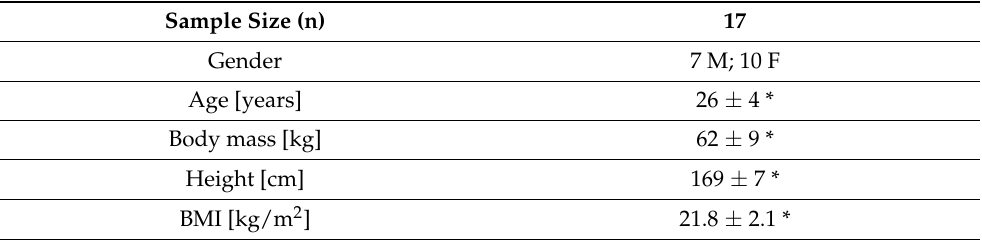
Table 1. Characteristics of study participants.